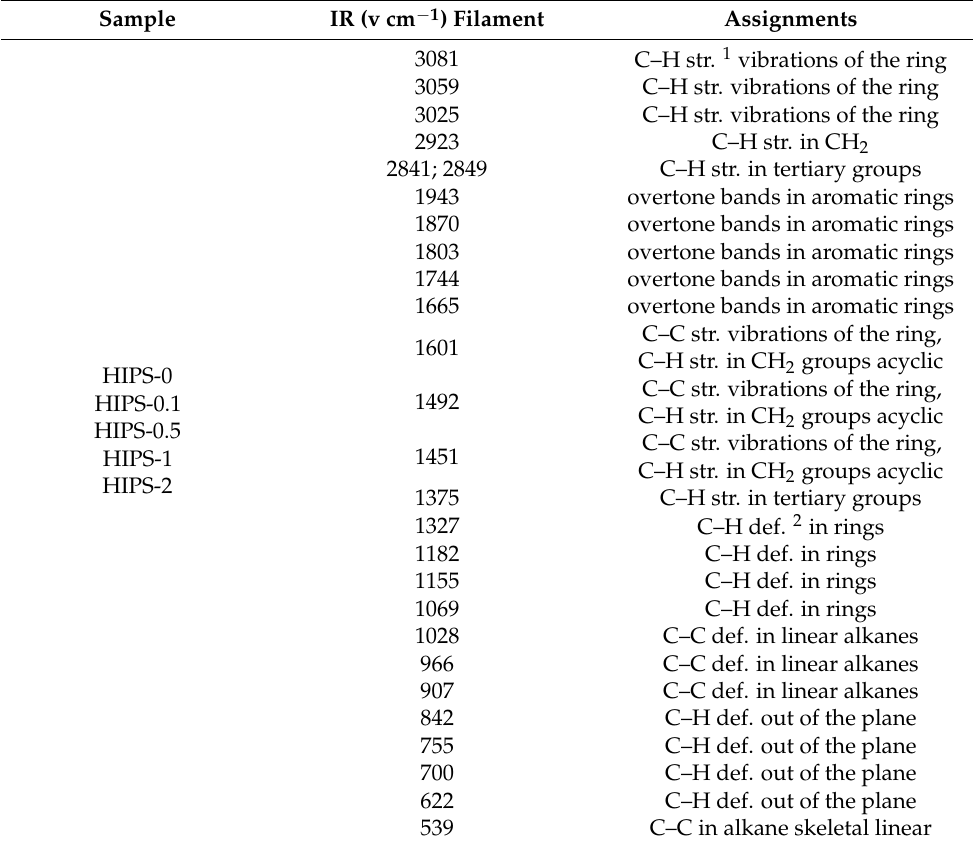
Table 2. Characteristic wavenumbers of the bands observed in the IR assignments for studied samples